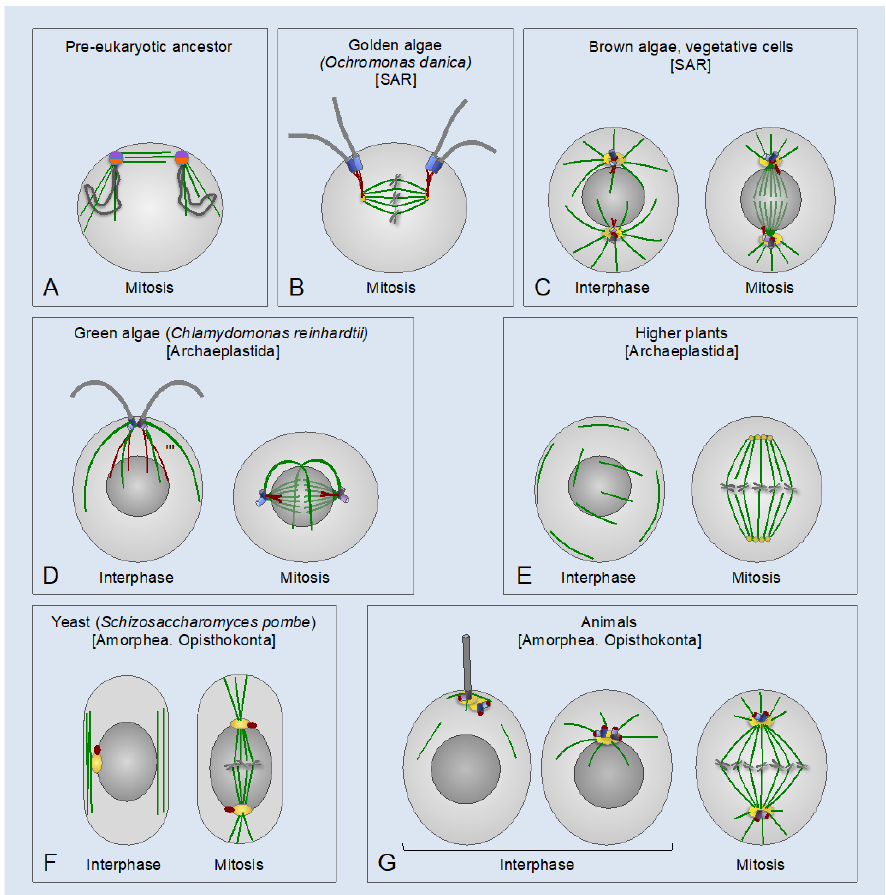
Figure 1. Centrosomes and the basal body apparatus in different eukaryotic lineages. ( A ) Putative pre-eukaryotic ancestor, which had circular chromosomes (dark grey loops) associated with a precursor centrosome with a dual centrosome and kinetochore function (purple and orange half-circles, respectively). The precursor centrosome was still attached to the surface membrane [42]. Microtubules (MTs) are in green. ( B – G ) Eukaryotes of different lineages. Centrioles / basal bodies are in blue or light purple; flagella are in grey; microtubules (MTs) are in green; pericentriolar material (PCM) is in yellow; the centrin-containing structures are in red. Higher plants ( E ) lack Polo-like kinase 1 (PLK1) and the apparent orthologs of the PCM proteins involved in γ -tubulin ring complex ( γ -TuRC) anchoring and activation in animals. Conceivably, plant-specific γ -TuRC-anchoring and activating factors form centrosome-like MT-organizing centers (MTOCs), which organize spindle poles in higher plants [(yellow circles in ( E )] [66]. Taxonomic supergroups are indicated in square brackets. SAR: stramenopiles, alveolates, and